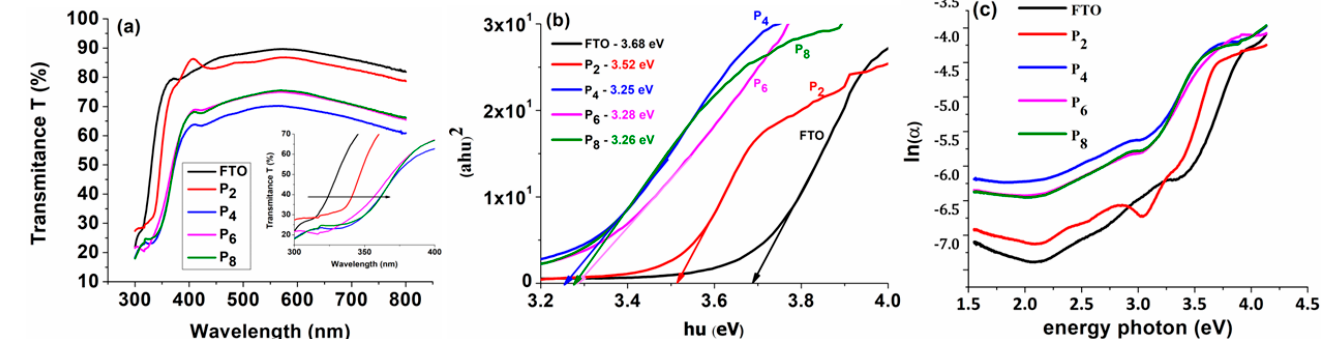
Figure 3. ( a ) Optical transmittance; ( b ) plot of ( α h ν ) 2 versus h ν ; and ( c ) ln( α ) versus photon energy plot for TiO 2 thin films deposited on an FTO substrate from solution 1, using different number of dip-coating layers.